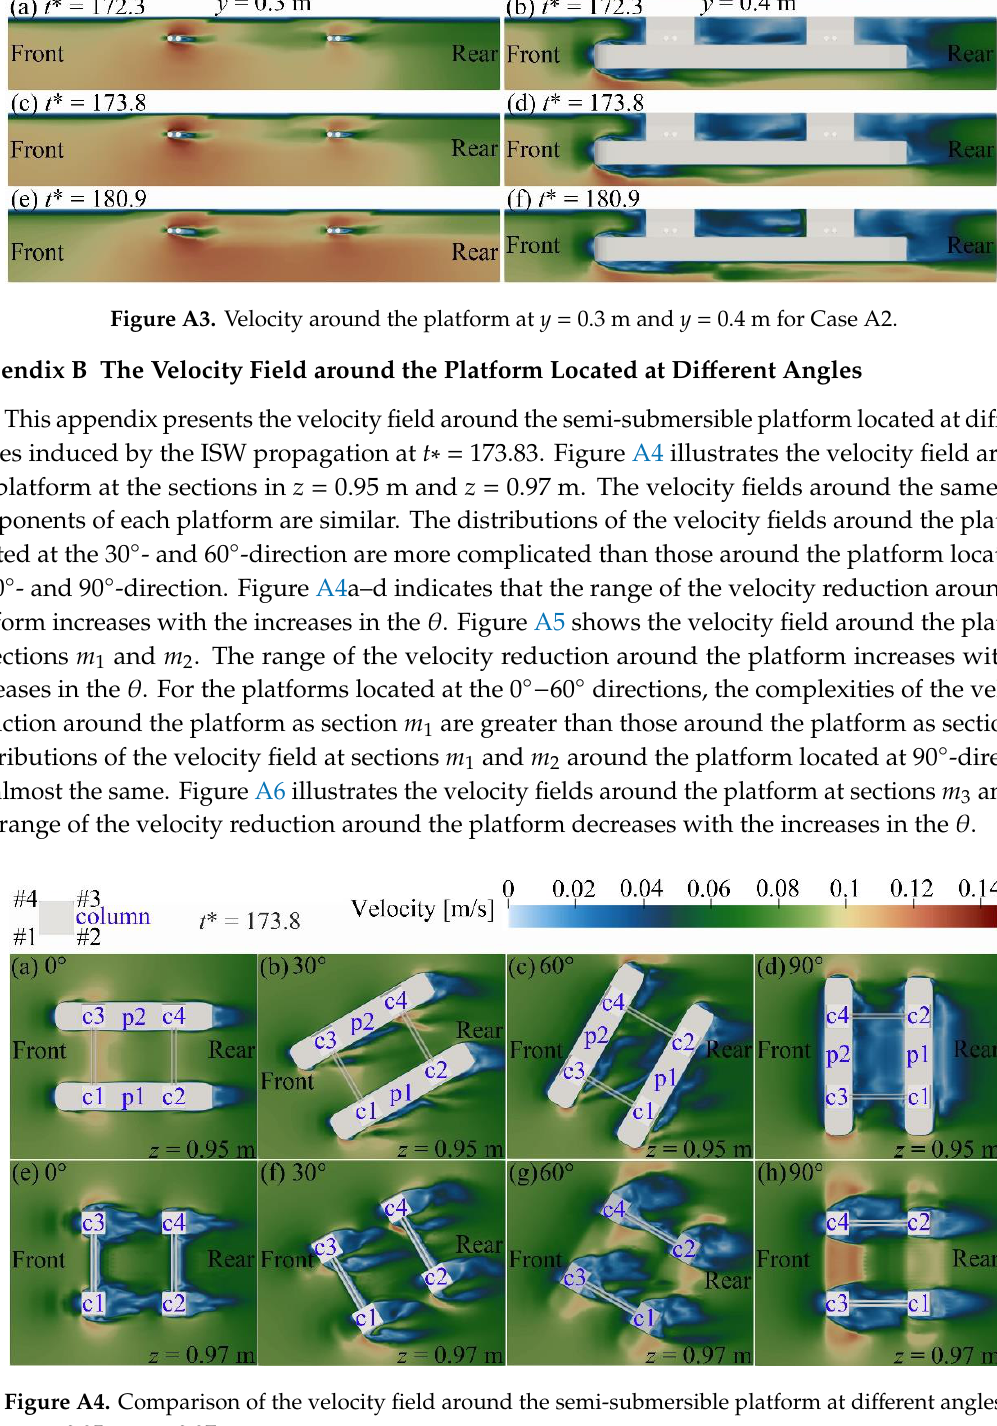
Figure A2. Velocity around the platform at x = 11.90 m and x = 12.10 m for Case A2.